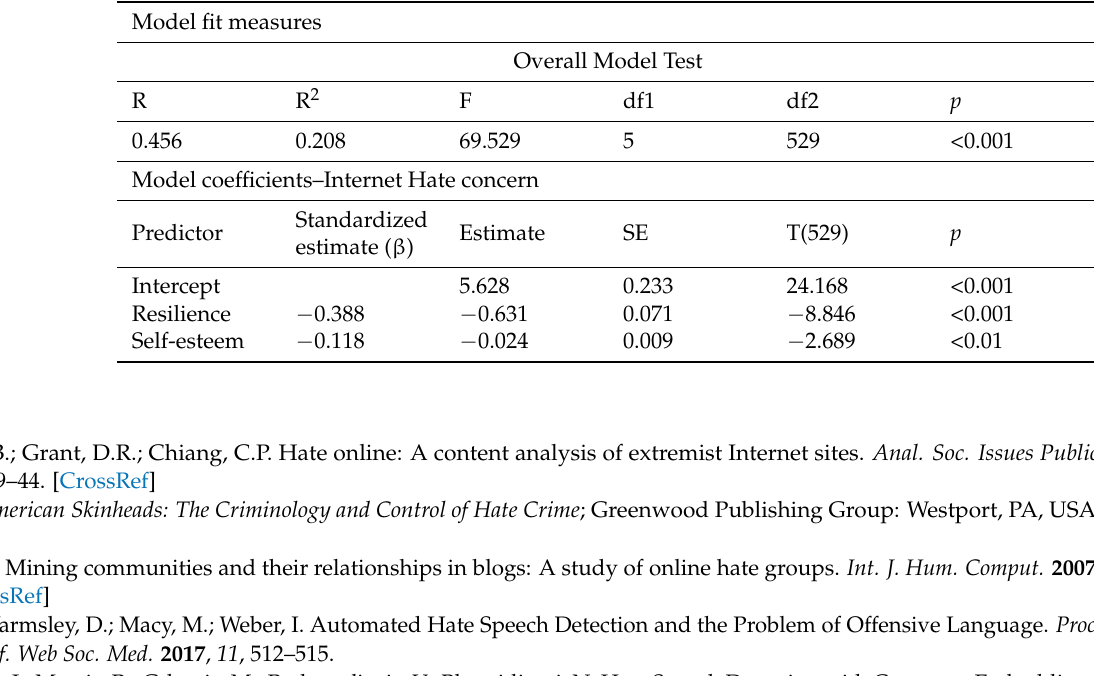
Table A3. Regression model on Internet hate concern in ordinary Internet users ( n =